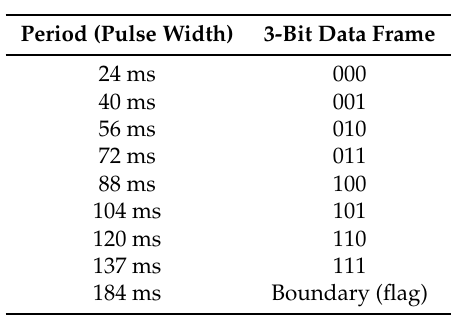
Table 1. Encoding/decoding in the proposed PWM method.